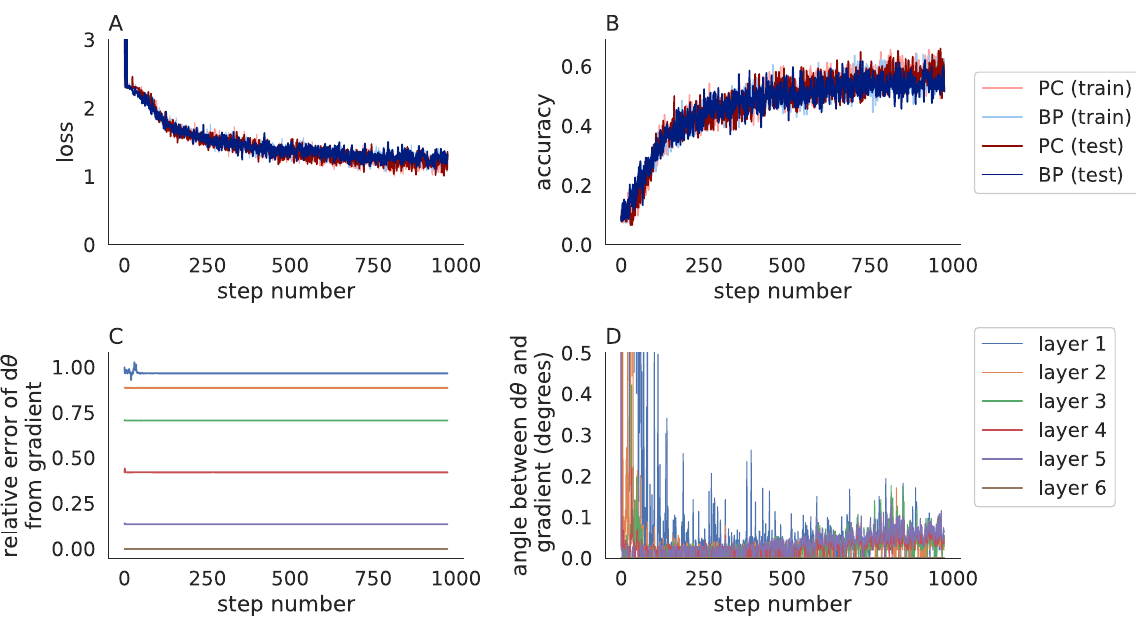
Fig 5. Predictive coding modified by the fixed prediction assumption compared to backpropagation in convolutional neural networks trained on CIFAR-10. Same as Fig 3 except a larger network was trained on the CIFAR-10 data set. The accuracy of predictive coding with the fixed prediction assumption is similar to backpropagation and parameter updates are similar to the true